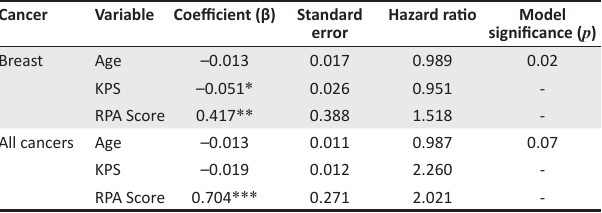
TABLE 5: Univariate proportional hazards of continuous variables affecting survival in patients with brain metastases. Cancer Variable Coefficient (β) Standard